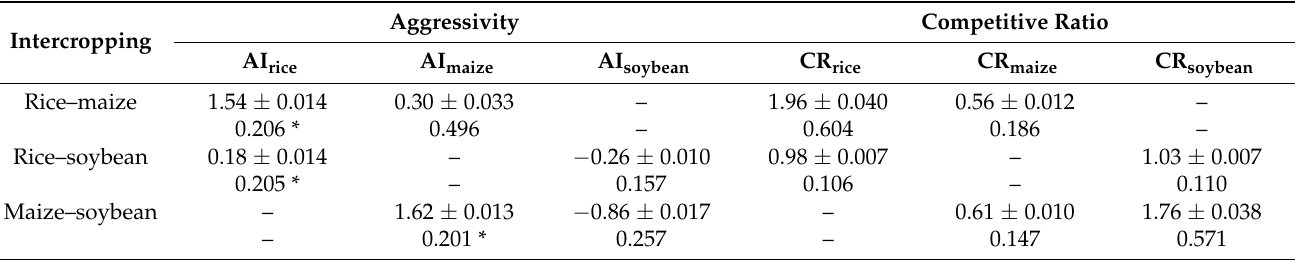
Table 5. Estimated values of aggressiveness index (AI) and competitive ratio (CR) for different IPs in comparison with MPs on rainfed areas of western Indonesia with a wet climate.